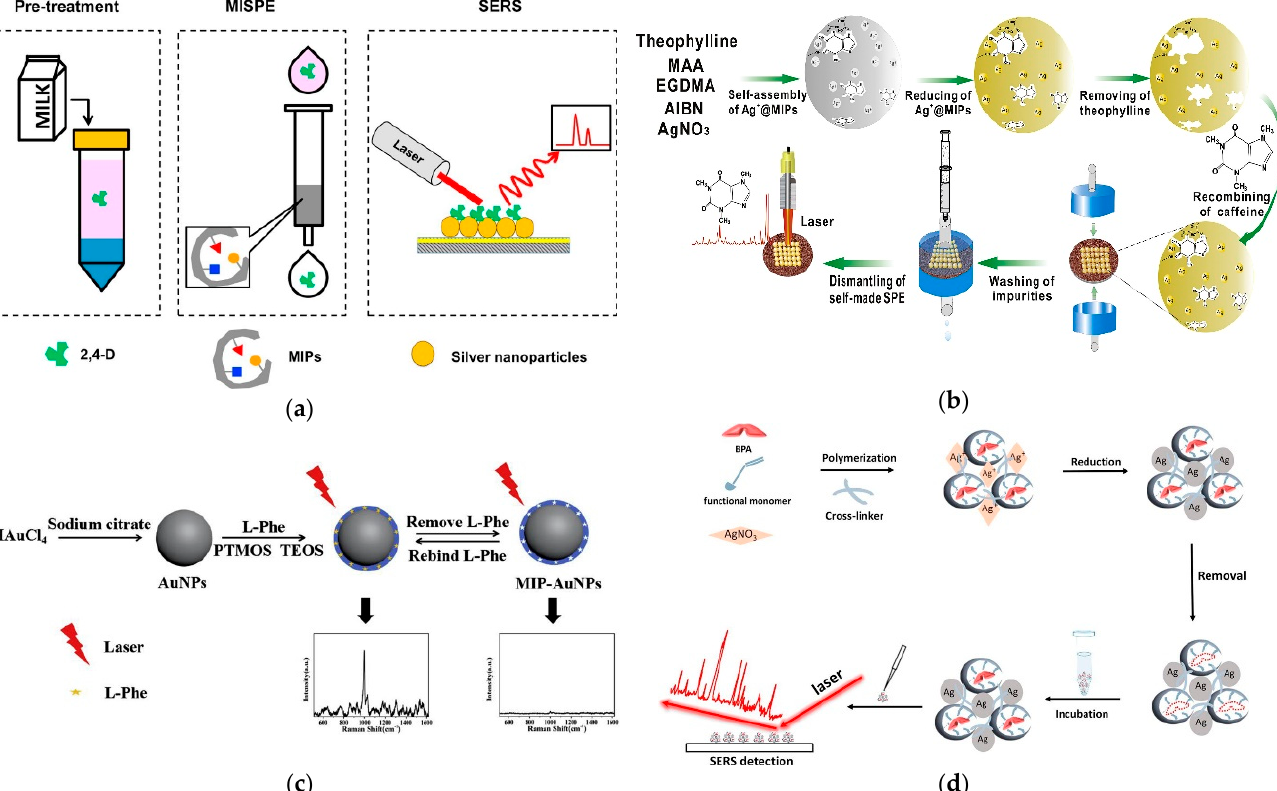
Figure 4. Example of MIP SERS scheme application for analysis ( a ). 2,4-dichlorophenylacetic acid; ( b ). caffeine; ( c ). L-Phenylalanine; and ( d ) Bisphenol A. Reuse with permission from [51,128,137,142]. Li et al., developed an analytical method for 2,6-dichlorophenol using SiO 2